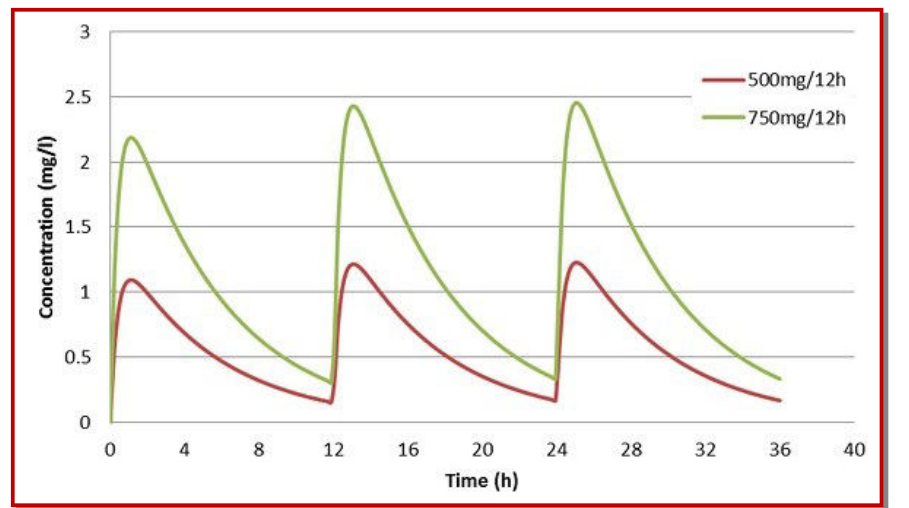
Figure 1: Simulated ciprofloxacin concentrations in plasma for the dosage regimens of 500 mg/12 hourly and 750 mg/12